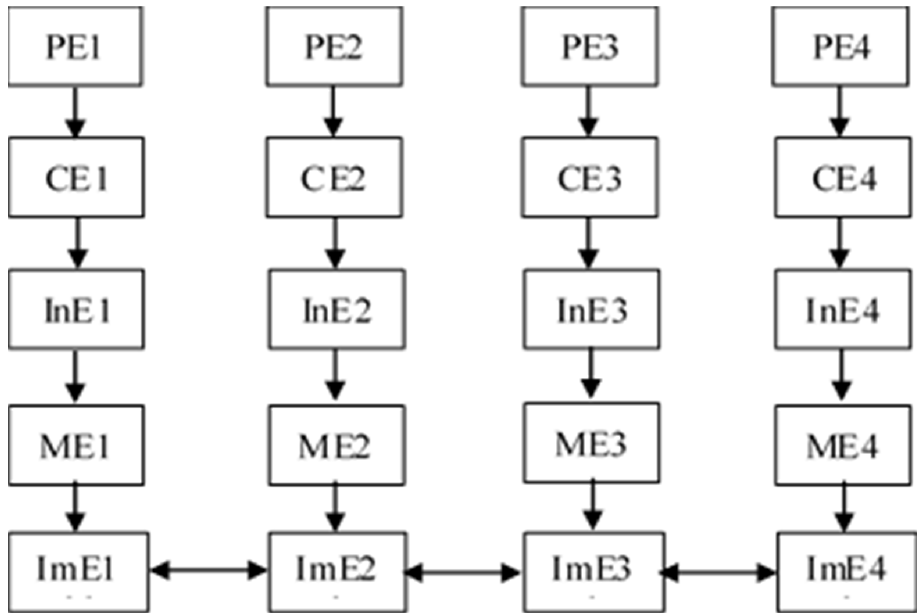
Figure 4. The Updated Evaluation Steps of Involuntary Resettlement Based on the Meta-model of Evaluation. (Note: Each number indicates one monitoring and evaluation unit, including “1” for “Progress of Resettlement Implementation and the Use of Resettlement Funds”, “2” for “Resettlement of the APs’ Productivity and Lives”, “3” is “Public Participation, Appeal, and Grievance”, and “4” is “Workings and Efficiency of The Agencies responsible for Resettlement”).